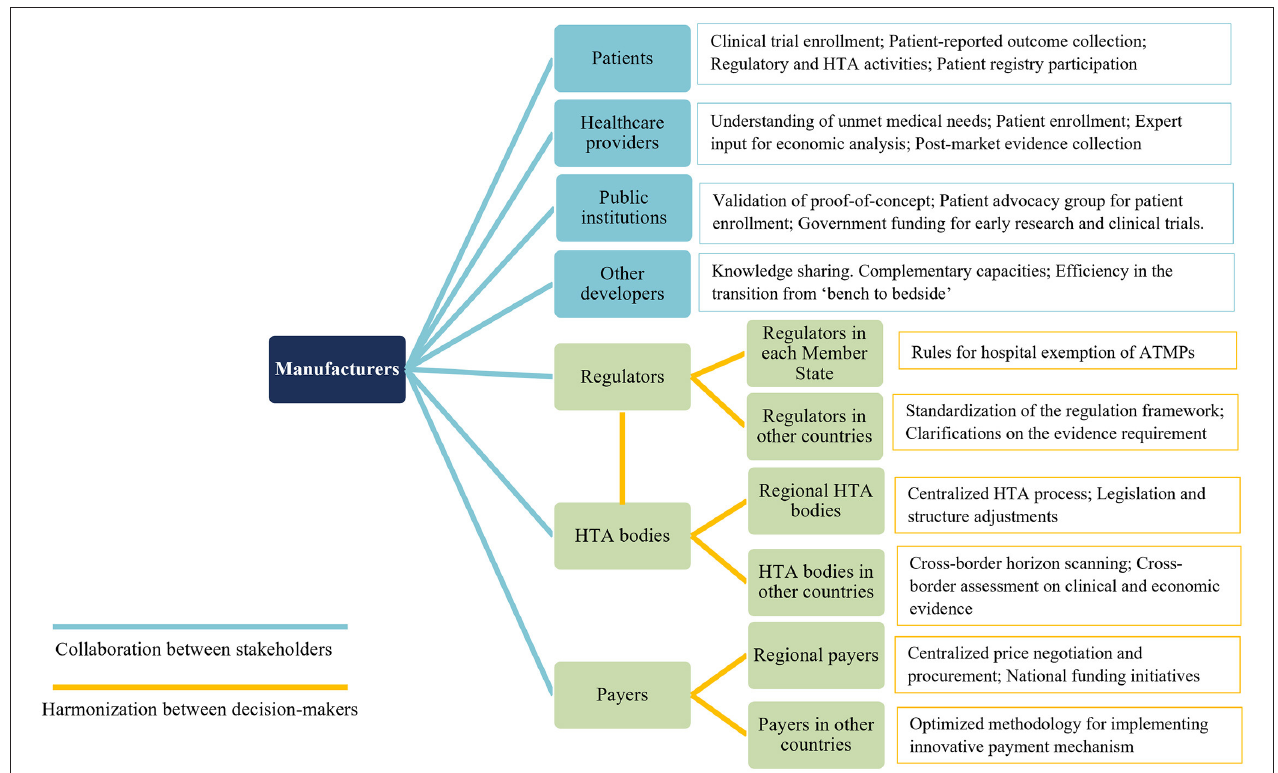
FIGURE 2 | Key points for future collaboration and harmonization related to ATMPs. ATMPs, advanced therapy medicinal